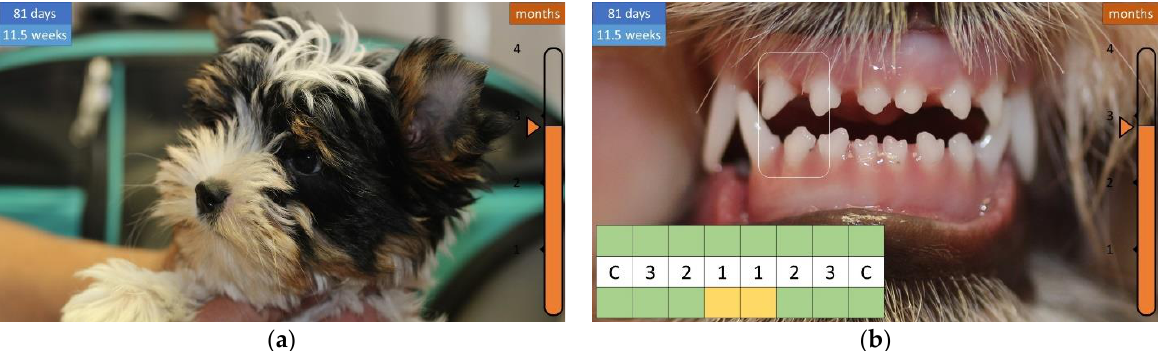
Figure 10. Development of the coat and teeth in a 11.5-week-old puppy. ( a ) Long coat ( “ tousled ” ). ( b ) The upper incisors are spaced apart.